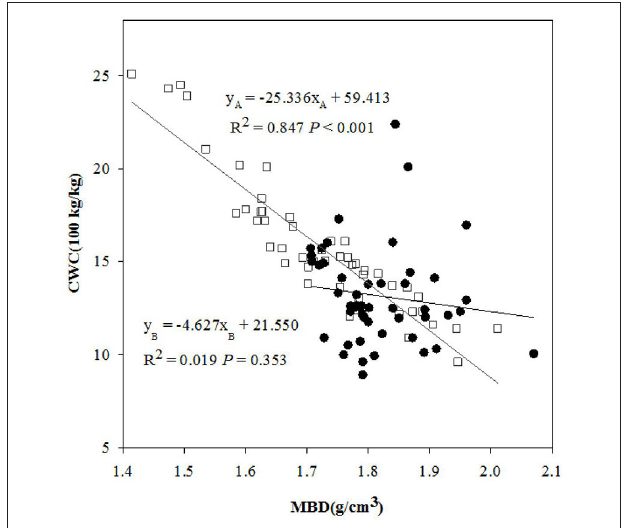
FIGURE 4 | Relationship between maximum bulk density (MBD, g cm − 3 ) and critical water content (CWC, 100kg kg − 1 ). Open and closed symbols refer to horizon A and horizon B,